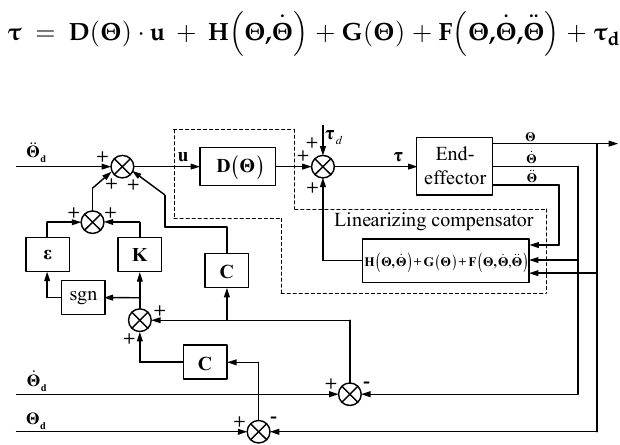
Figure 3. The sliding mode variable structure control block diagram.